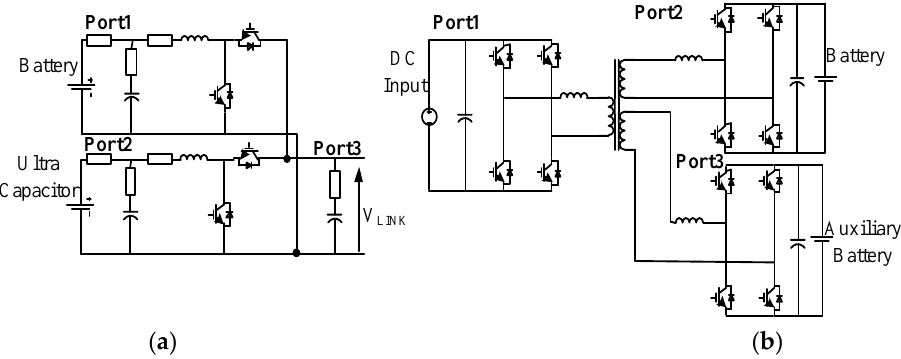
Figure 1. Different types of three-port active bridge (TAB): ( a ) DC link interfacing (DI); ( b ) Magnetic couple interfacing (MI).